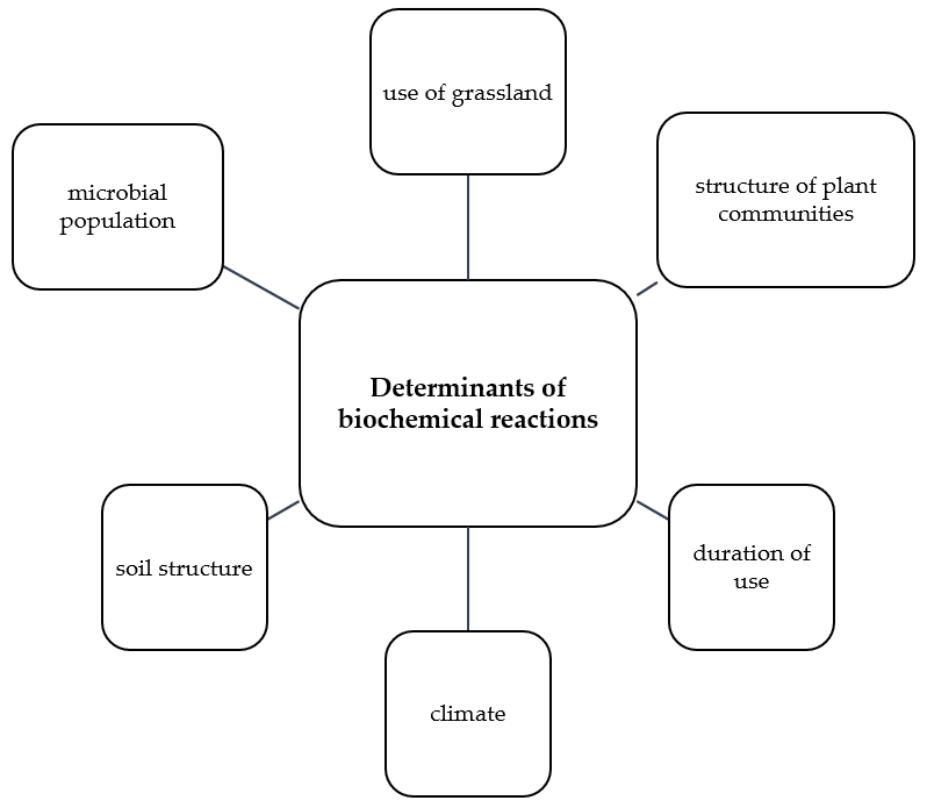
Figure 1. Determinants of biochemical reactions occurring in grassland soils.